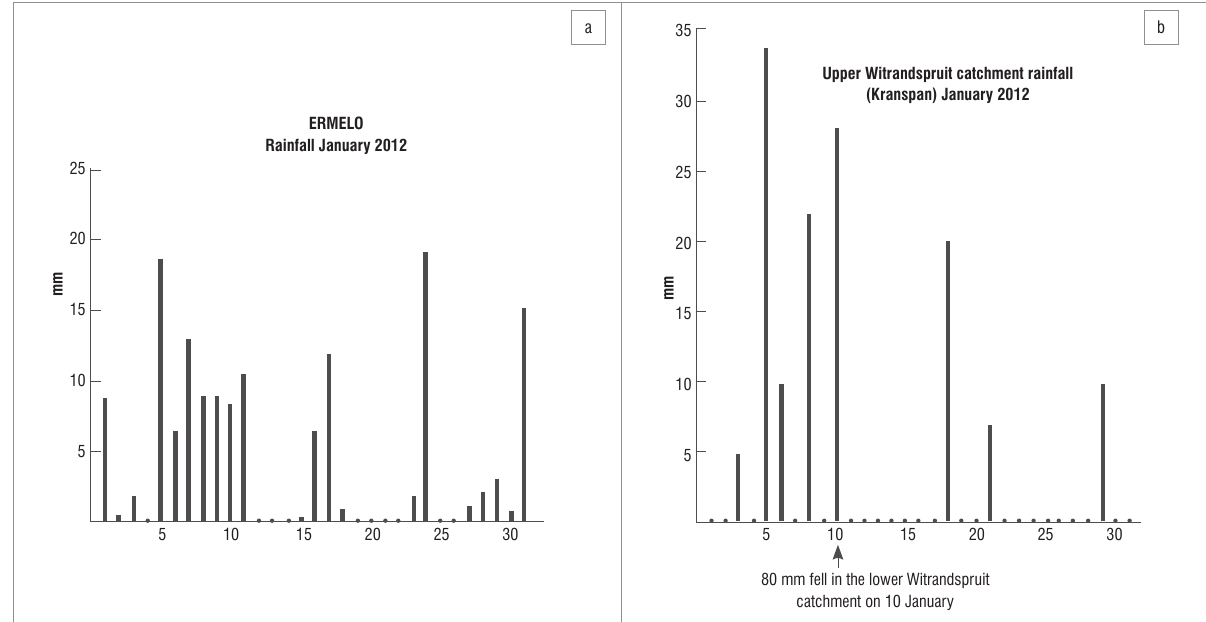
Figure 5: (a) Daily rainfall for Ermelo in January 2012 and (b) daily rainfall at Kranspan in January 2012 (see Figure 3 for